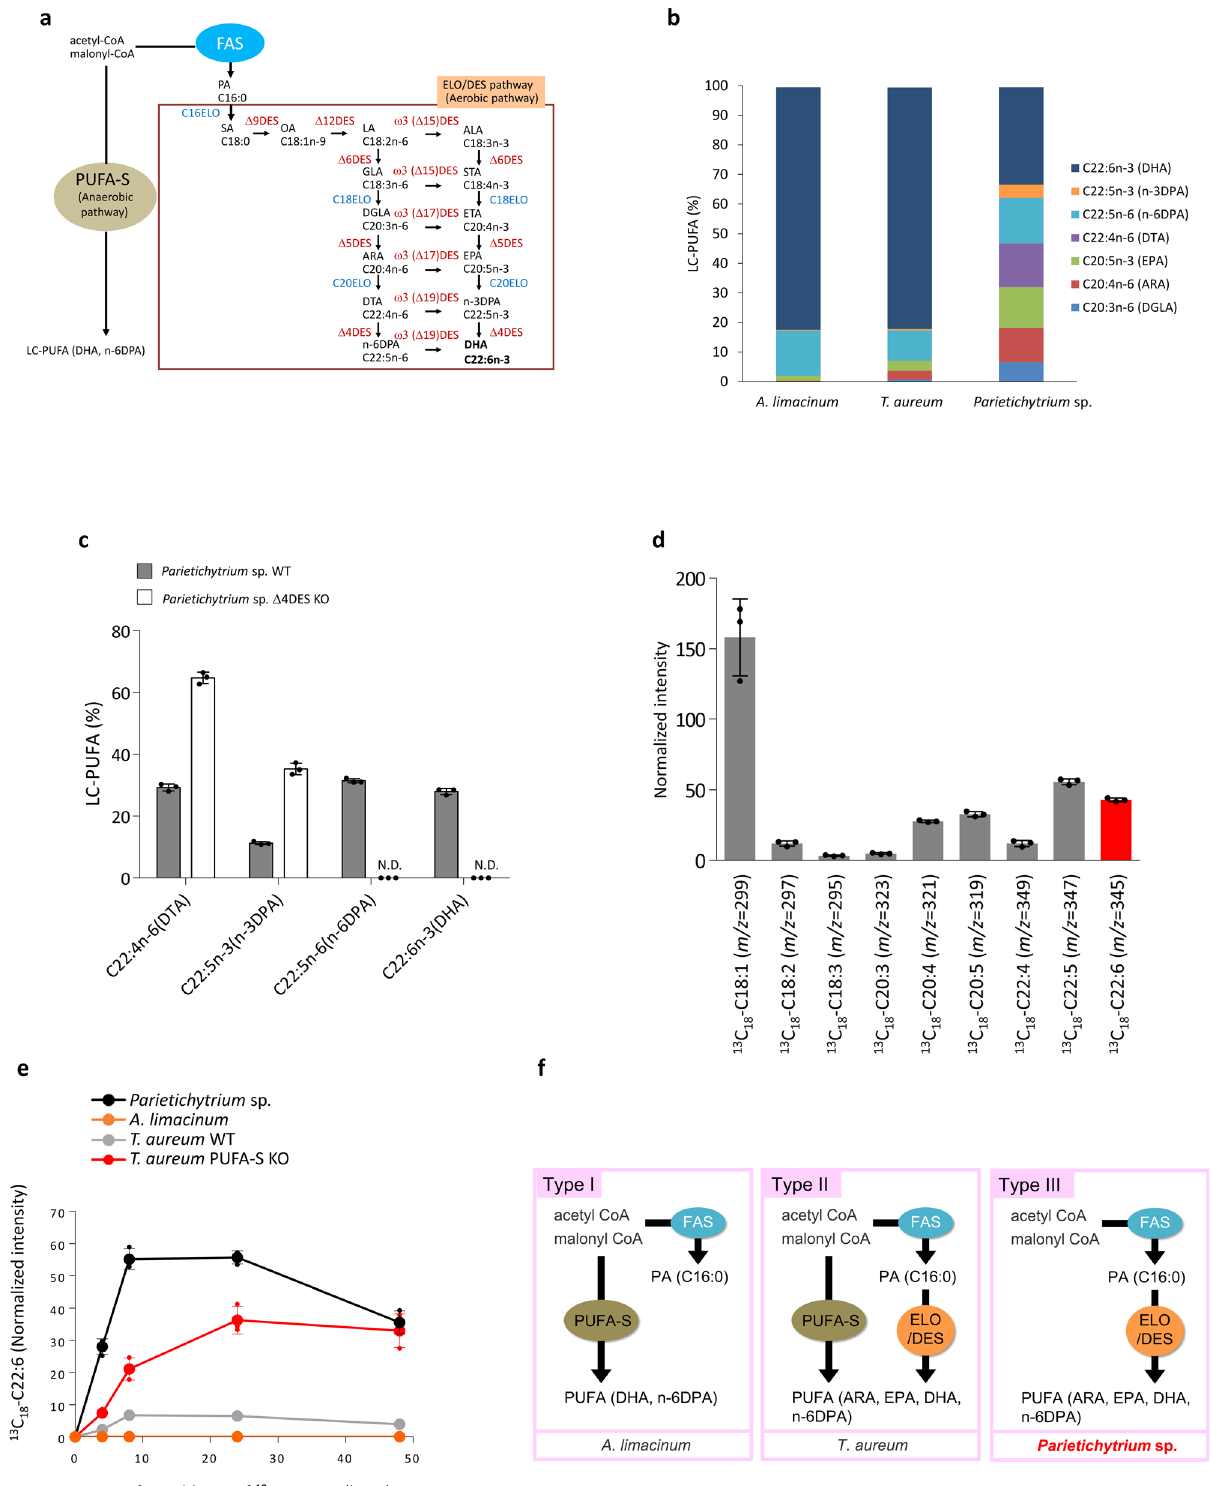
To con fi rm that Parietichytrium sp. produces DHA through the ELO/DES pathway, we traced the DHA synthesis of Par- ietichytrium sp. using 13 C-labeled OA ( 13 C 18 -C18:1) as a pre- cursor. Parietichytrium sp. was cultured in GY medium containing 13 C 18 -C18:1, and total fatty acids were extracted from the cells after cultivation for 24 h. The fatty acid fraction was then analyzed by LC-ESI MS/MS as described in the Methods, and